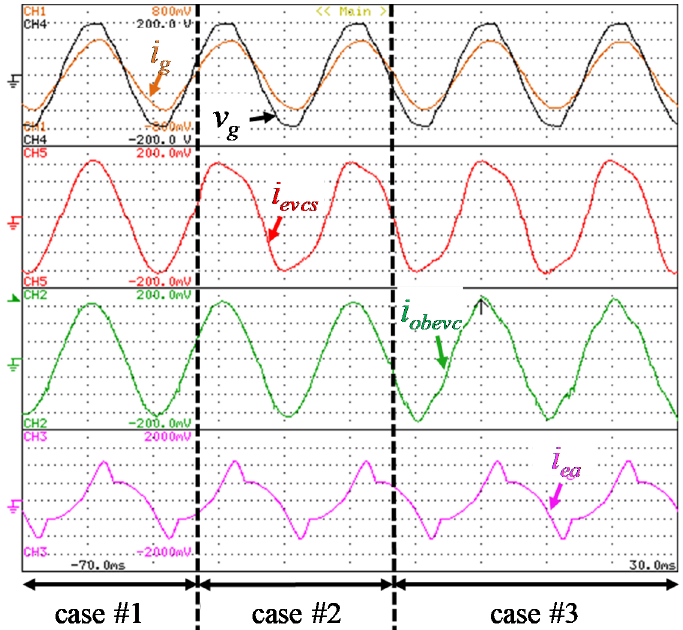
Figure 26. Experimental results during the MF-EVCS operation combined with the operation of an on-board EV charger (compensating current harmonics): Ac-side voltage ( v g : 50 V/div); Total home current ( i g : 20 A/div); Ac-side current of the MF-EVCS ( i evcs : 5 A/div); Ac-side current of the on-board EV charger ( i obevc : 5 A/div); Current consumed by the electrical appliances ( i ea : 5 A/div).